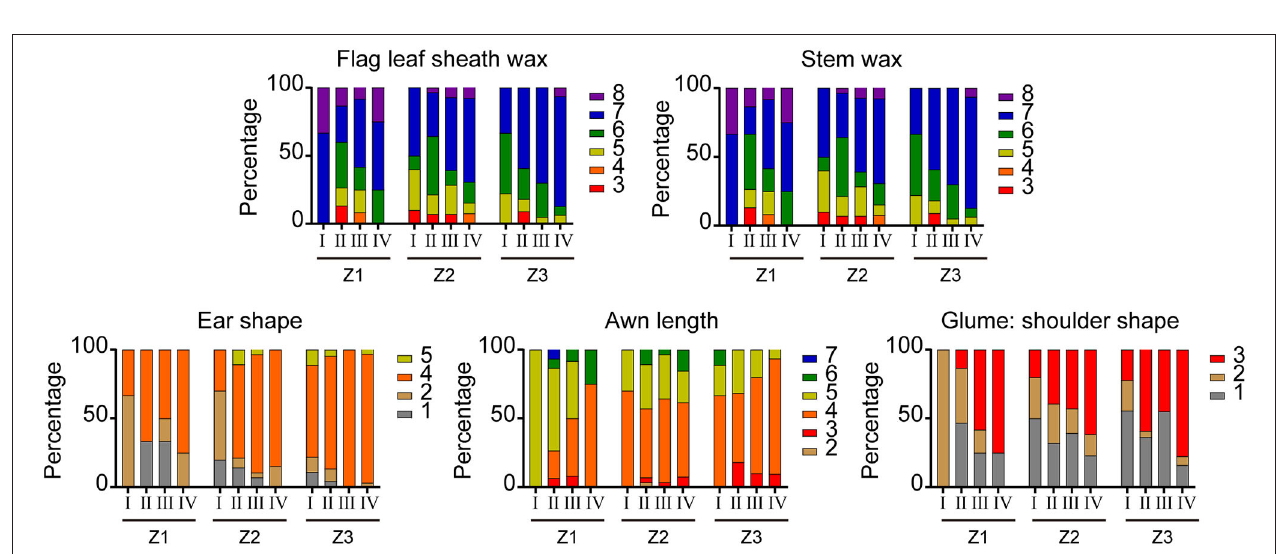
FIGURE 3 | Changes in five visually assessed characteristics of wheat varieties with the second artificial selection trend. The legends have the same meaning as in Figures 1 , 2 .